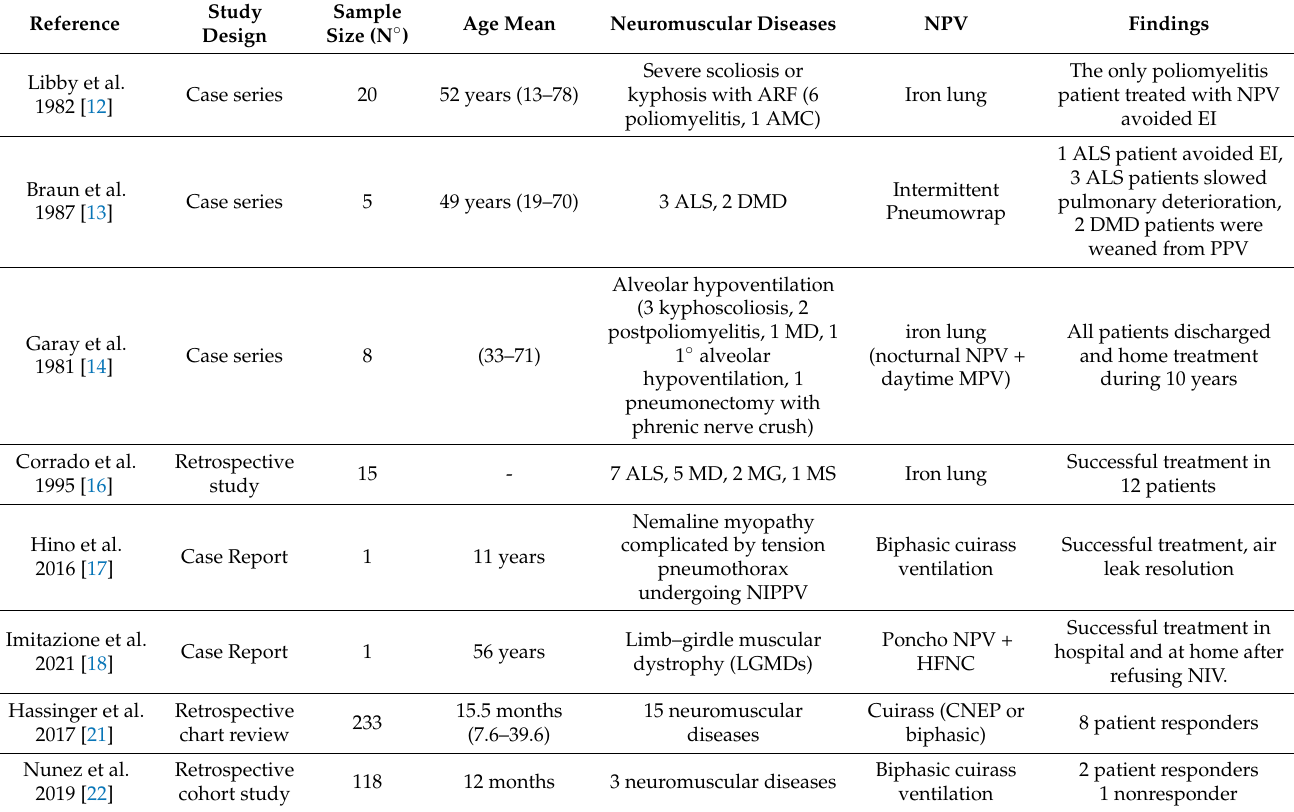
Table 2. Studies on NPV in NMD patients with ARF. AMC: arthrogryposis multiplex congenital,